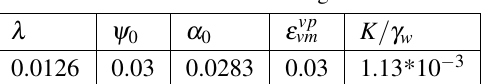
Table 1. Parameters in rheological